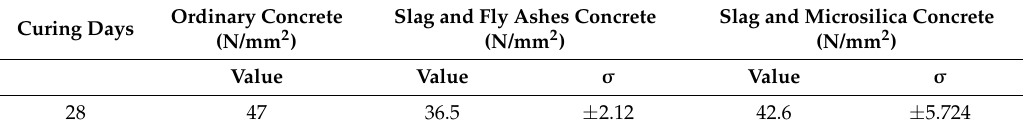
Table 6. Mean values and standard deviations of the mechanical characteristics of slag and microsilica concrete. Specific Weight Compressive Failure Flexural Failure Stress Tensile Failure Stress Curing Days (daN/m 3 ) Stress (N/mm 2 ) (N/mm 2 ) (N/mm 2 ) Value 31.2 - Table 7. Compressive strength for the different concrete types. Ordinary Concrete Slag and Fly Ashes Concrete Curing Days (N/mm 2 ) (N/mm 2 )